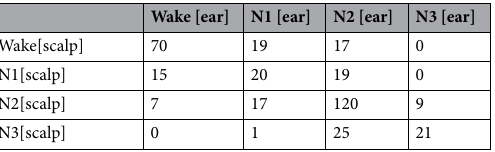
Table 1. Contingency table of epochs for the Wake versus Sleep stages (N1, N2 and N3) for all